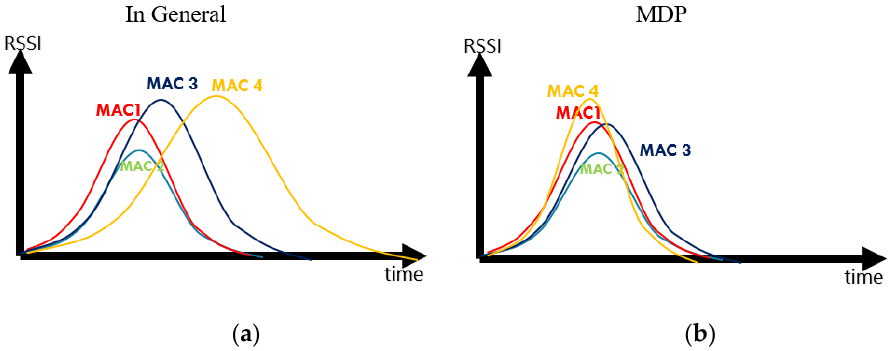
Figure 6. RSSI of MDP. ( a ) Mobile devices in different vehicles. ( b ) Multiple devices in the same vehicle